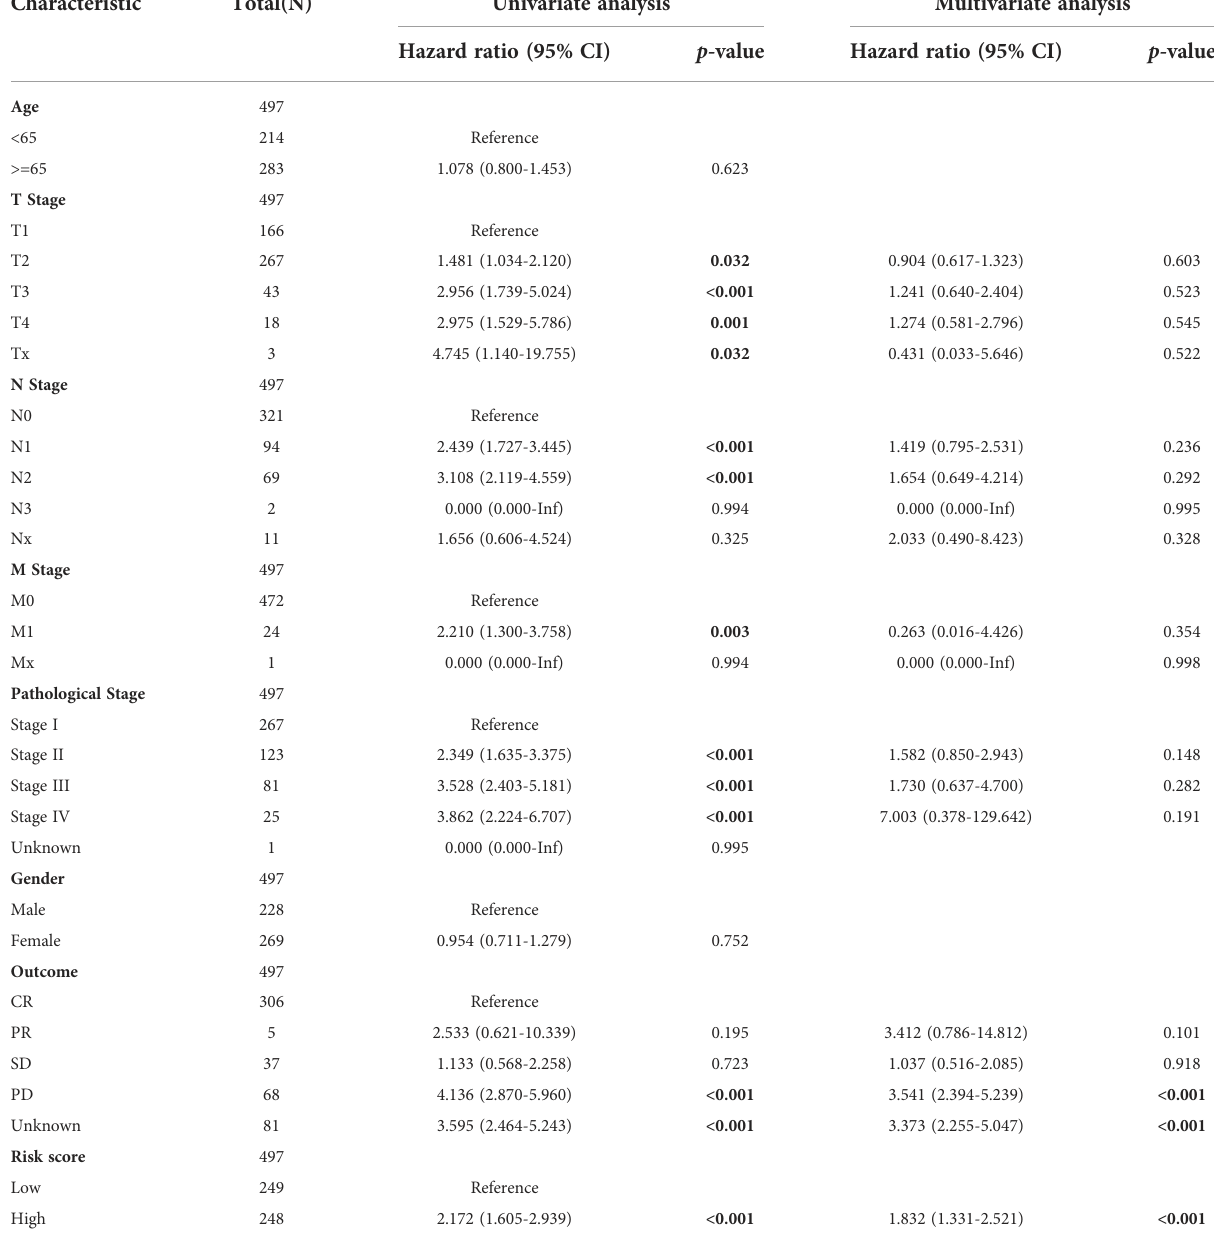
TABLE 2 The univariate and multivariate Cox regression analyses of clinical characteristics for overall survival in LUAD patients.